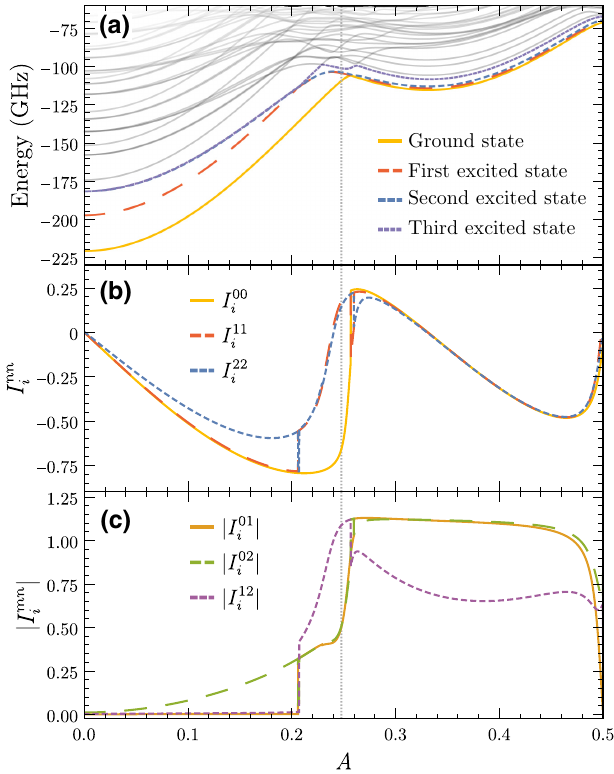
FIG. 2. (a) The first 50 energy eigenvalues as a function of A , the flux penetration per loop. The relevant levels for this anal- ysis are indicated in the legend; higher levels are grayed out. (b) Expectation values of the persistent currents in the ground state, first excited state, and second excited state for each loop ( i = 1, 2, 3) of the circuit shown in Fig. 1(b) as a function of A . (c) Magnitudes of three of the off-diagonal elements of the loop- current operators in the eigenbasis for each loop ( i = 1, 2, 3) as a function of A . The true currents require rescaling by I C (here taken to be 1). The circuit is periodic on A ∈ { 0, 1 } and anti- symmetric about A = 0.5, and hence only 0 ≤ A ≤ 0.5 is shown here. The parameters chosen for these plots are E J / h = 4 E C / h ≈ , E J / E (cid:3) ≈ 40, C C = 6 C J , and C G = 45 GHz, where E C = e 2 2 C J 0.02 C J . Offset charge is tuned such that the total Cooper pair number in the ground state is approximately 1.2, with N g 1 = N g 2 = N g 3 ≈